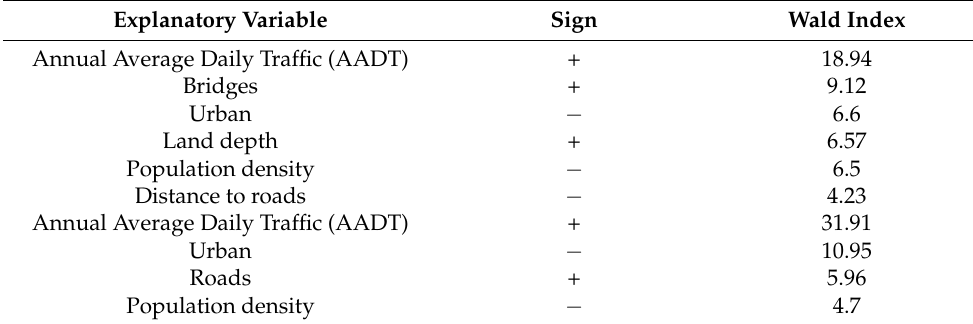
Table 2. Explanatory variables obtained for native forest species. The table on the left corresponds to the complete model, whereas the one on the right corresponds to the anthropic model. Sign: indicates the sign of the variable in the model. Wald Index: indicates the relative importance of each variable in the model.